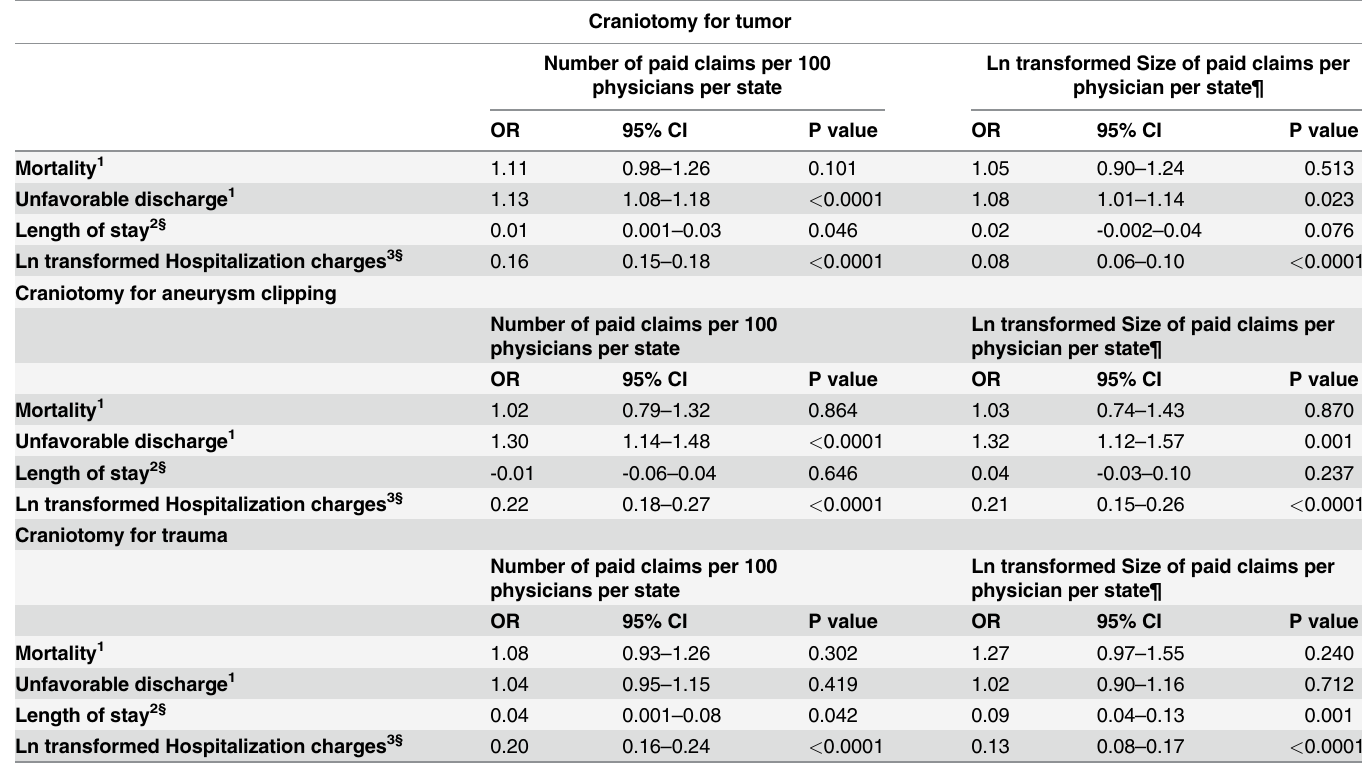
Table 4. Regression models for primary outcomes and variables of interest in the 3 most common procedure